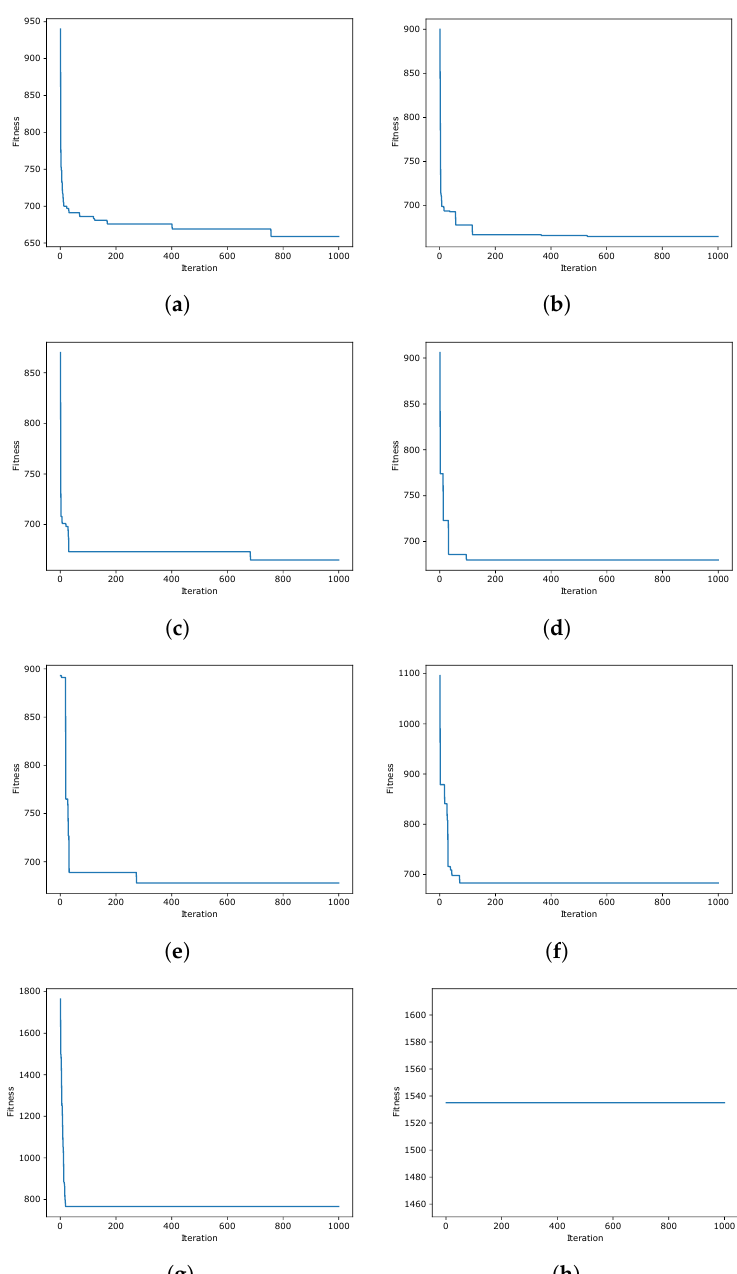
Figure 6. SCA instances coverage when resolving the scp49 instance of the SCP. Instance